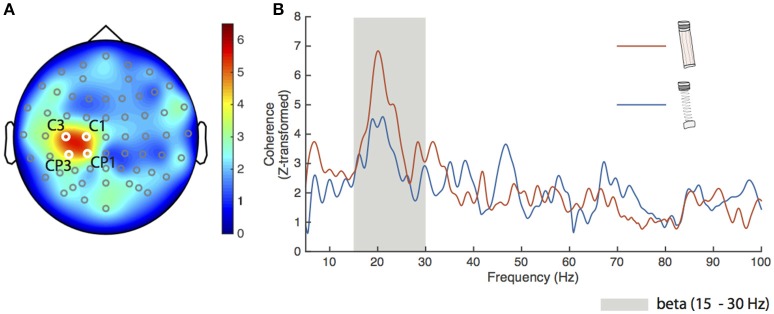
Results for the dowel-low task. (A) Grand average Z-transformed FDI-EEG coherence head map for the dowel-low task with all electrode locations marked. The four electrodes used for statistical analyses were C1, C3, CP1, and CP3 (labeled) with respective Z-transformed coherence values of 4.81, 5.26, 4.66, and 4.54. The cluster of electrodes appears over the left sensorimotor cortex. (B) Average coherence spectra of the four electrodes shown in (A) for the spring-high (blue trace) and dowel-high (orange trace) tasks. The beta frequency band (15–30 Hz) is shown as the gray shaded area. Peak coherence of the average for the spring-low condition was 4.59 at 21.05 Hz and for the dowel-high condition, 6.84 at 20.1 Hz.